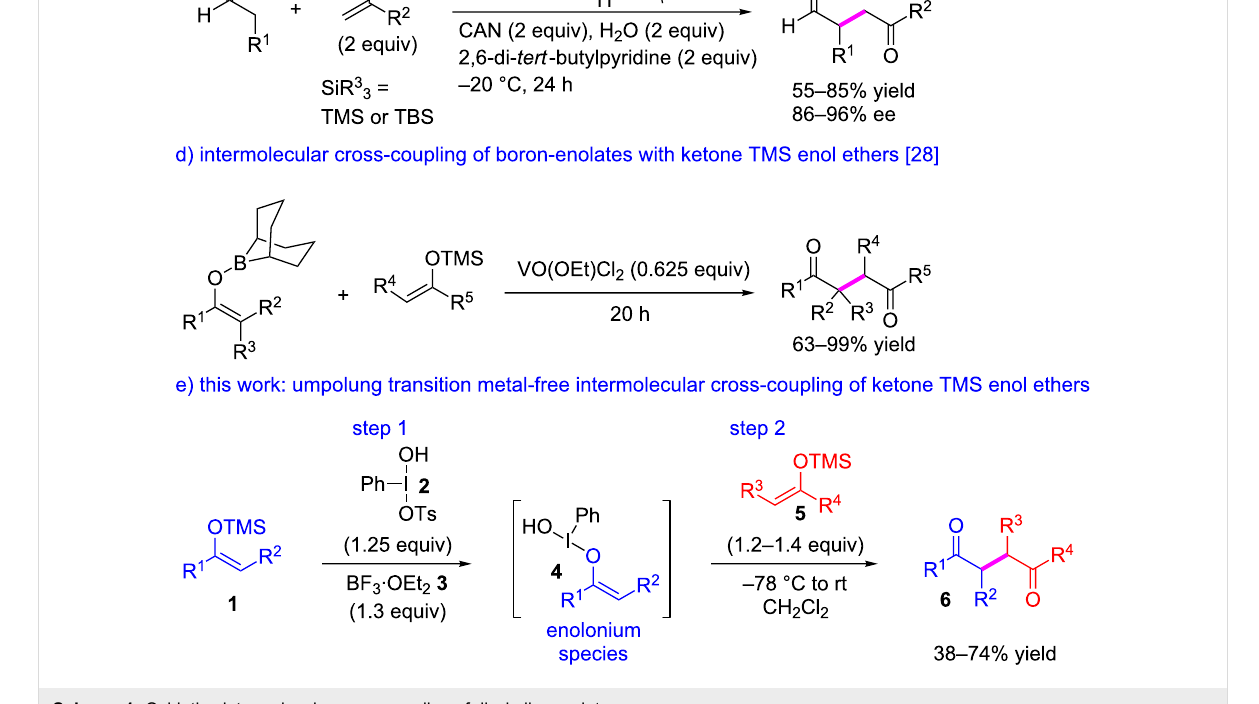
Scheme 1: Oxidative intermolecular cross-coupling of dissimilar